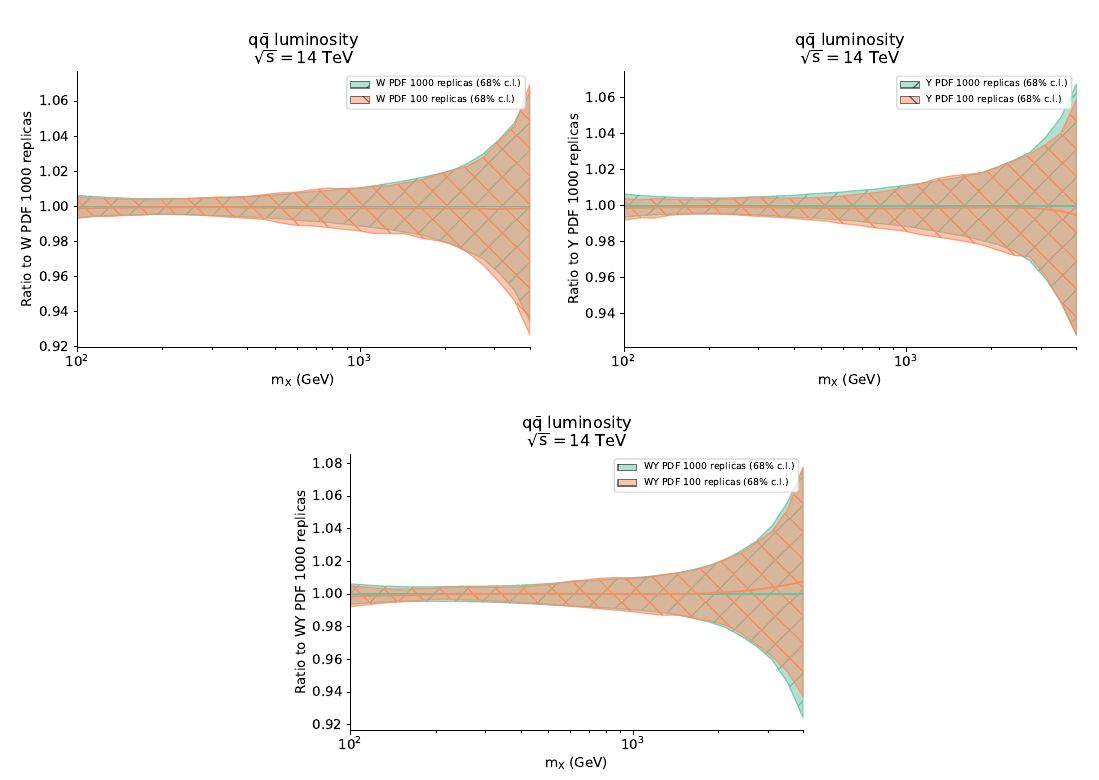
Figure 17 . The q ¯ q luminosity of the 100 replica (low statistics) fits normalized to the 1000 replica (high statistics) fits for various SMEFT scenarios considered in this work. Shown in the top left (top right) is the individual W ( Y ) scenario, while the lower panel is the combined ( W, Y ) scenario with HL-LHC projections being used in the